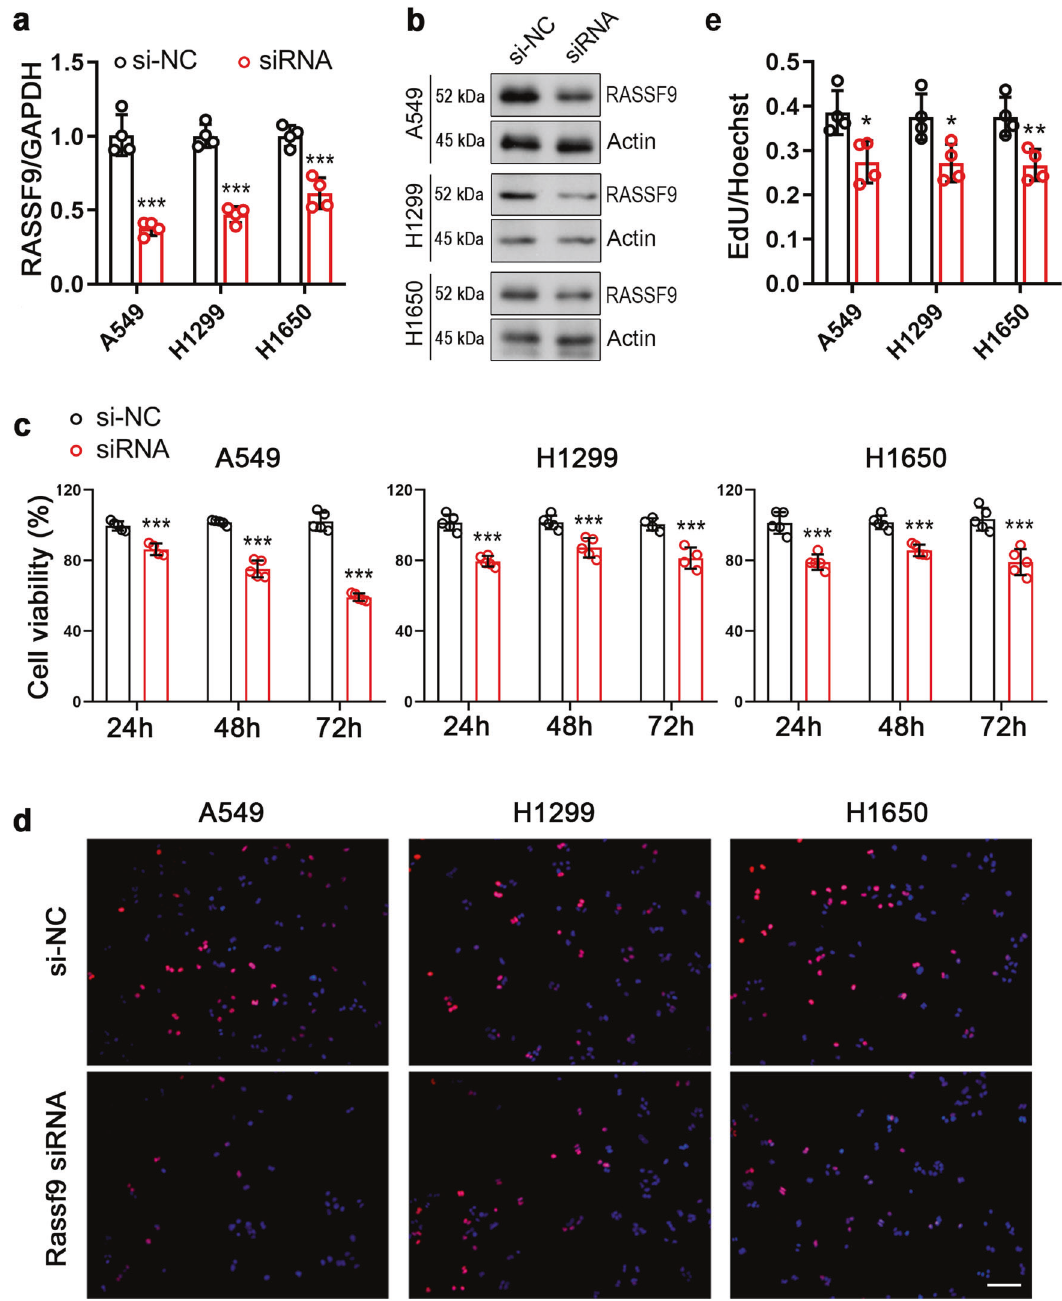
Fig. 3 Knockdown of Rassf9 suppresses NSCLC cell proliferation. a Knockdown of Rassf9 by siRNA. A549, H1299, and H1650 cells were transfected with Rassf9 siRNA or negative control (si-NC). Forty-eight hours post-transfection, total RNA was extracted for gene expression analysis by qRT-PCR and GAPDH was used as a house-keeping gene. b The protein levels of RASSF9 were reduced by siRNA. Cell treatments were described in ( a ). Protein levels were analyzed by western blot and Actin was used a loading control. c Knockdown of Rassf9 decreases NSCLC cell viability. A549, H1299, and H1650 cells were transfected with Rassf9 siRNA or si-NC. Cell viability was analyzed by the method of MTT at 24 h, 48 h, and 72 h post-transfection. d Knockdown of Rassf9 reduces EdU incorporation. A549, H1299, and H1650 cells were transfected with Rassf9 siRNA or negative control (si-NC). Forty-eight hours post-transfection, cell proliferation was analyzed by EdU immuno fl uorescence assay. Scale bar = 500 μ m. e Quantitative analysis of EdU incorporation. Data are presented as means ± SD (error bars). * P < 0.05, ** P < 0.01, and *** P < 0.001. Student ’ s t